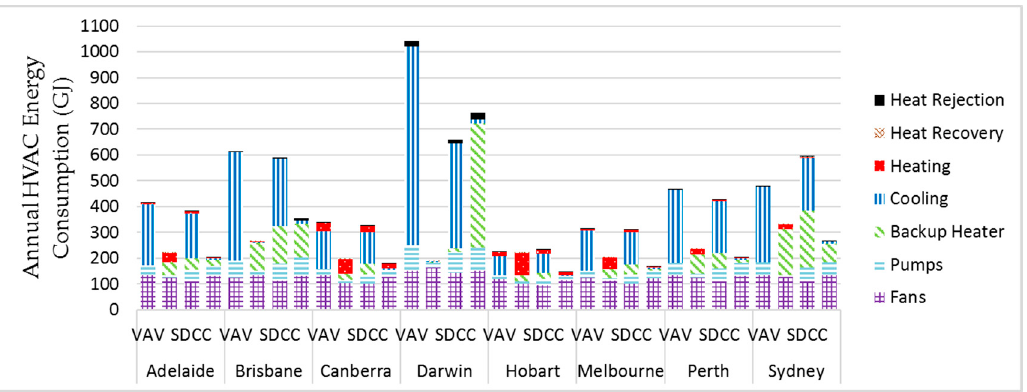
Figure 17. Annual HVAC electricity energy consumption.